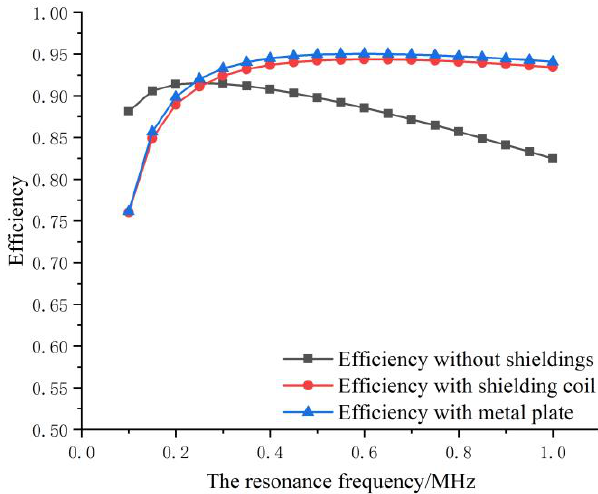
Figure 12. The power transmission efficiency changes with the resonance frequency.